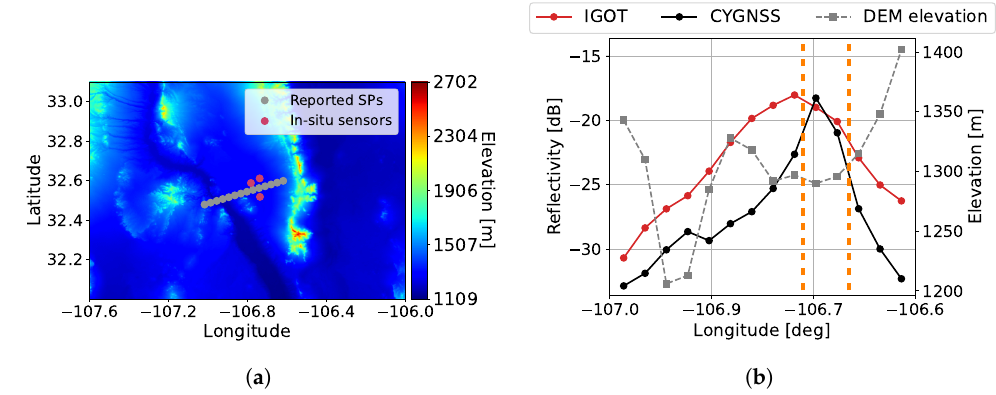
Figure 8. JER track 1: ( a ) Track elevation map; ( b ) Peak reflectivity. The SoilSCAPE sites are between the orange vertical lines.